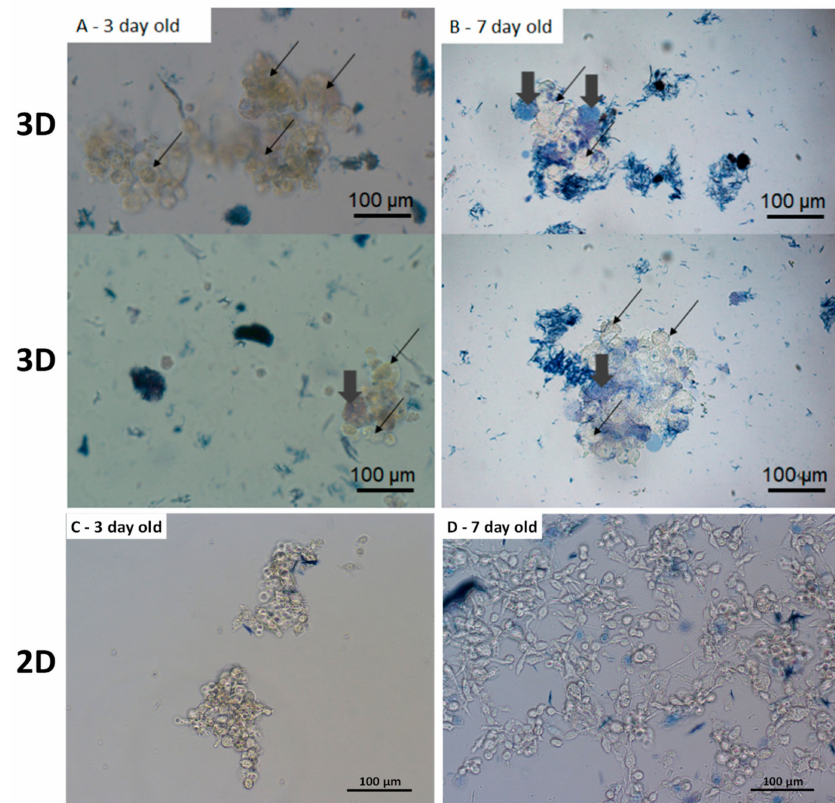
Figure 5. Images acquired in bright field of the cell MDA-MB231 cultured in 3D sca ff old and dyed with trypan blue immediately before the observation and posed on a microscopy glass. Images refer to cells cultured for ( A ) 3 days and ( B ) 7 days. Black arrows indicate alive cells, whereas, big grey arrows point on the dead cells. (20 × magnification). In the upper images of Figure 5 ( B ) (7 days of cultures) 9 cells among the 42 detected are blue (79% of viability), whereas, 11 cells of the 56 detected in the bottom image are blue (81% of viability). Panel ( C ) and ( D ) show the Trypan blue assay on a 2D cell culture seeded 3 days and 7 days, respectively, before observation (100% of